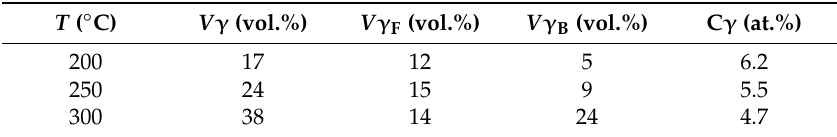
Table 4. Carbon content and Volume fraction of retained austenite with di ff erent transformation